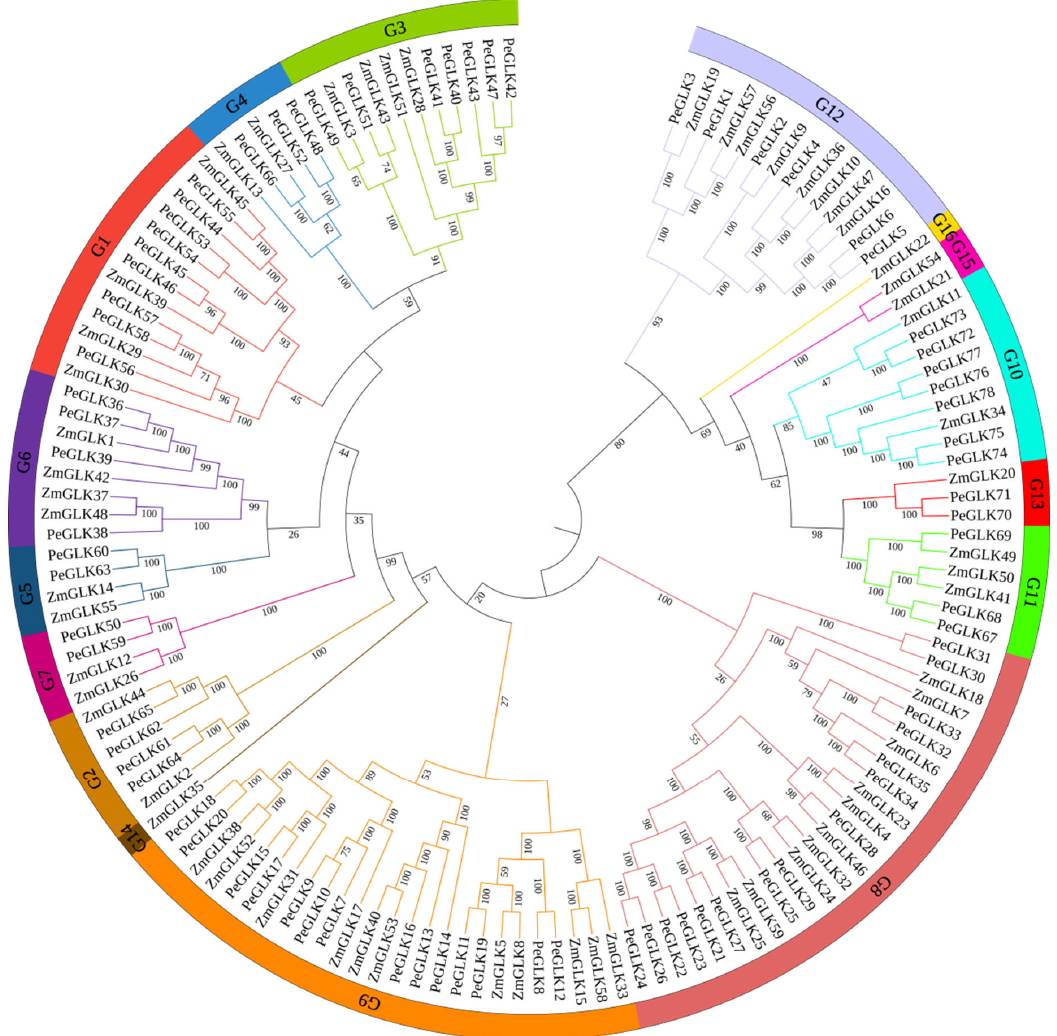
Figure 2. Phylogenetic analysis of GLK proteins of moso bamboo and maize. Tree was constructed using neighbor ‐ joining method with MEGA7.0. Each color represents one group in the branches, and 16 groups were found in total. The numbers at nodes indicate the bootstrap values per 1000 replicates determined by the neighbor ‐ joining method.